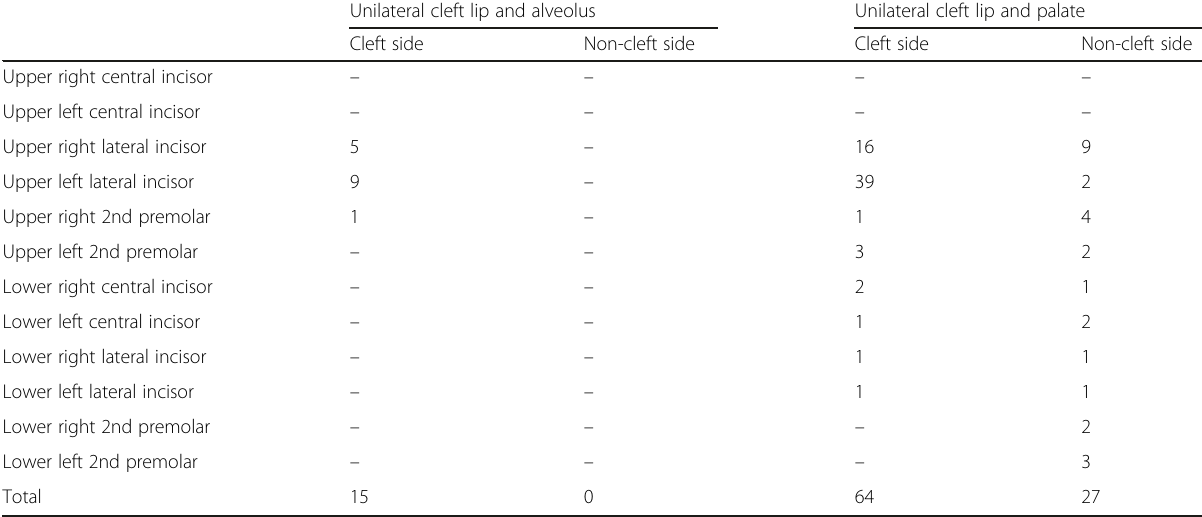
Upper right central incisor